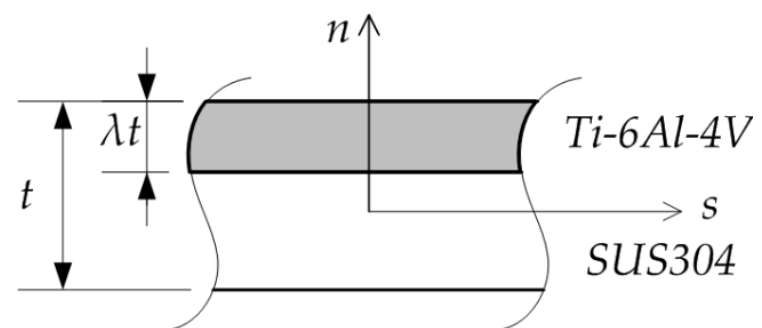
Figure 1. Bimetallic beam wall.